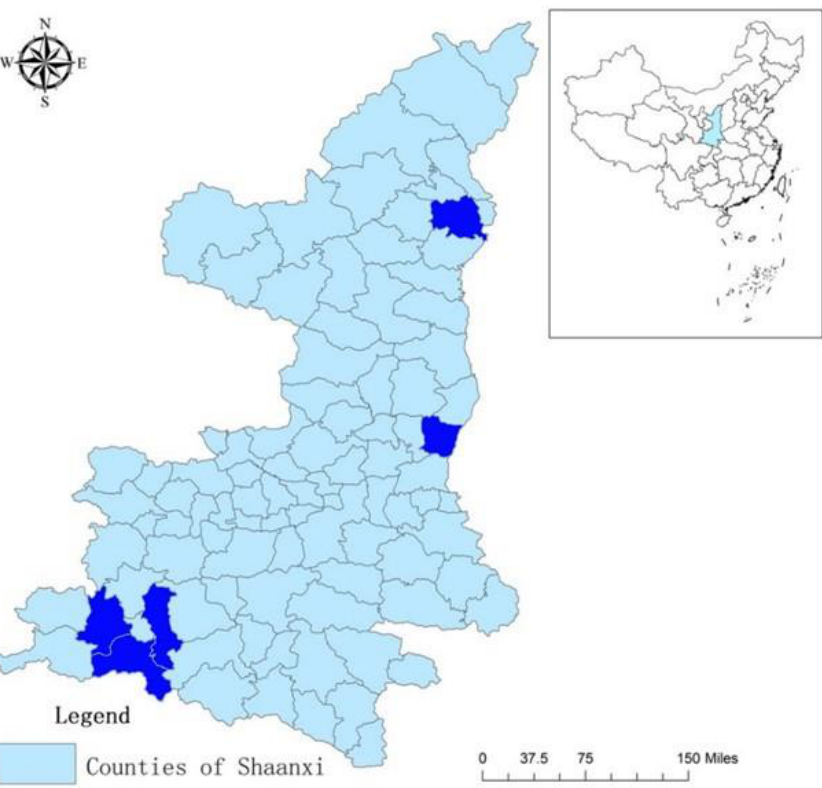
Figure 1. Study counties (dark blue) in Shaanxi province, China. Study counties clockwise from top: Suide, Heyang, Nanzheng, Chenggu, Mianxian. Source: Zhou et al. [29]. Sample counties colored using Adobe Photoshop (Adobe Inc., San Jose, CA, USA).